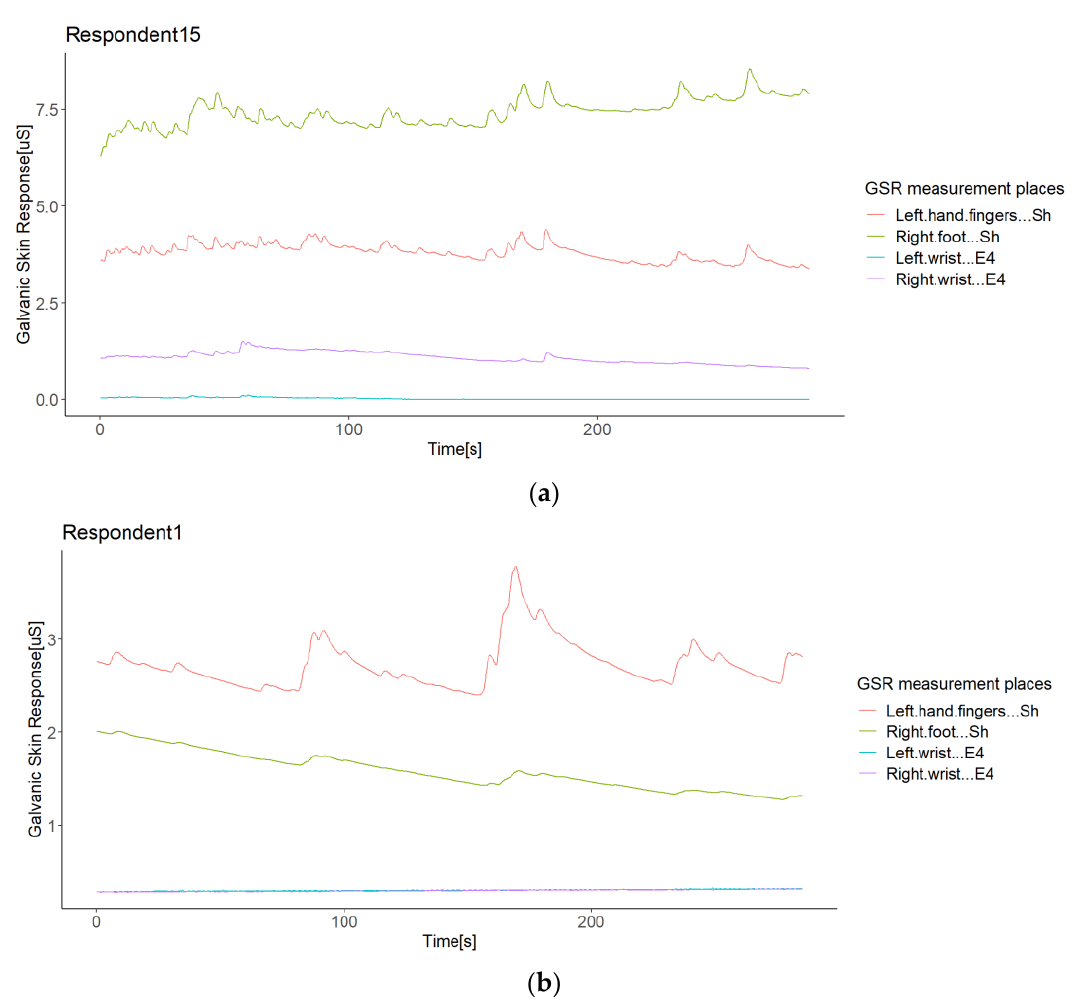
Figure 10. Illustration of the opposite directions of GSR signals in the same respondent (Respondent 15). A case of the same type of sensor: A respondent with negative correlations between different sensors ( a ); a respondent with positive correlations between sensors ( b ).